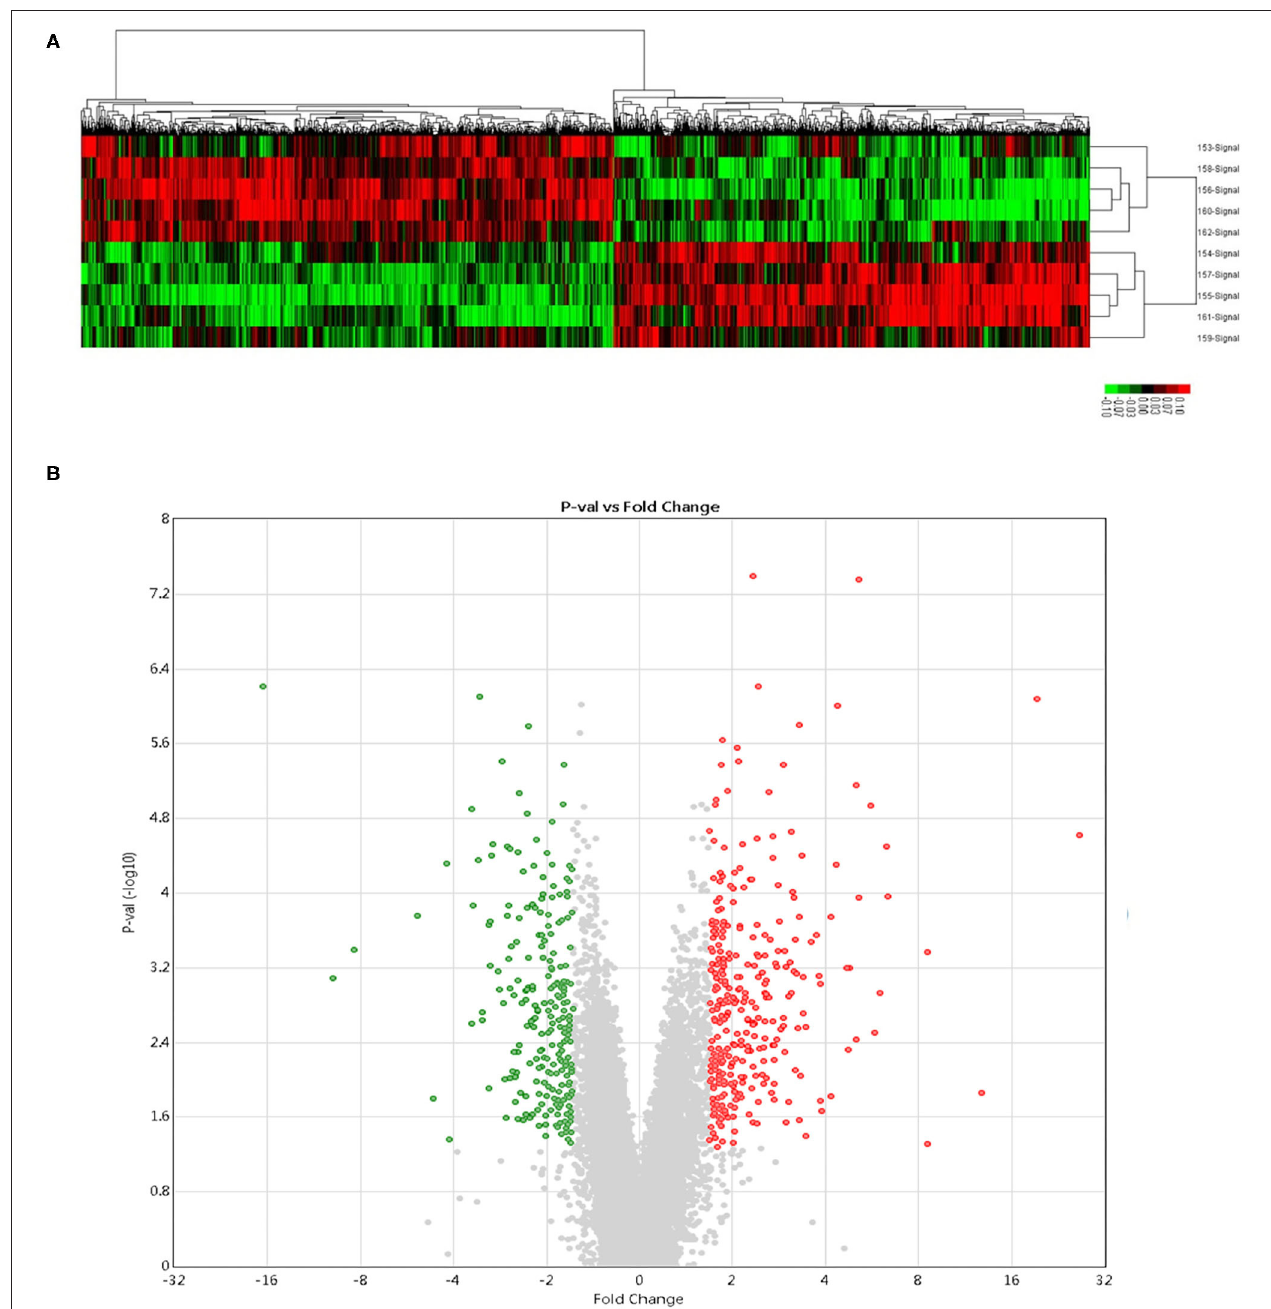
FIGURE 2 | Microarray gene analysis. (A) Hierarchical cluster analyses of DEGs. Each probe set is denoted by a single row of colored bars. Red: upregulated; green: downregulated; black: no change. Every line denotes a liver sample from control ( n = 5) and IUGR ( n = 5) newborn rats. (B) The volcano plot analysis of DEGs. Green color denotes upregulation; Red color represents downregulation. Genes with a significant change of more/ < 1.5-fold were selected.